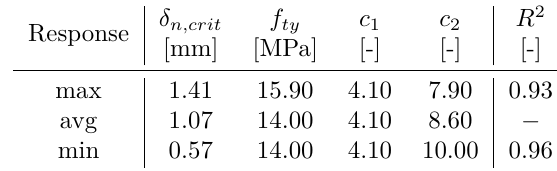
Table 2. Parameters of cohesive law calculated by sequentially linear approach to inverse analysis [23] of load vs. CMOD responses of CT specimens cut from arch base.